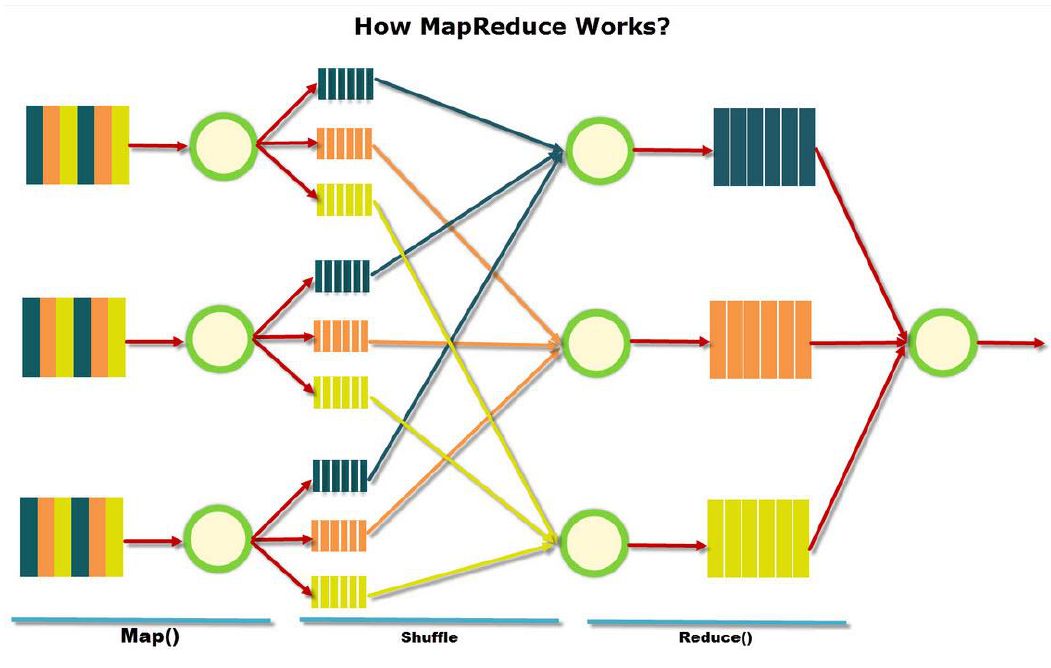
Figure 2. Visualization how Map-Reduce works